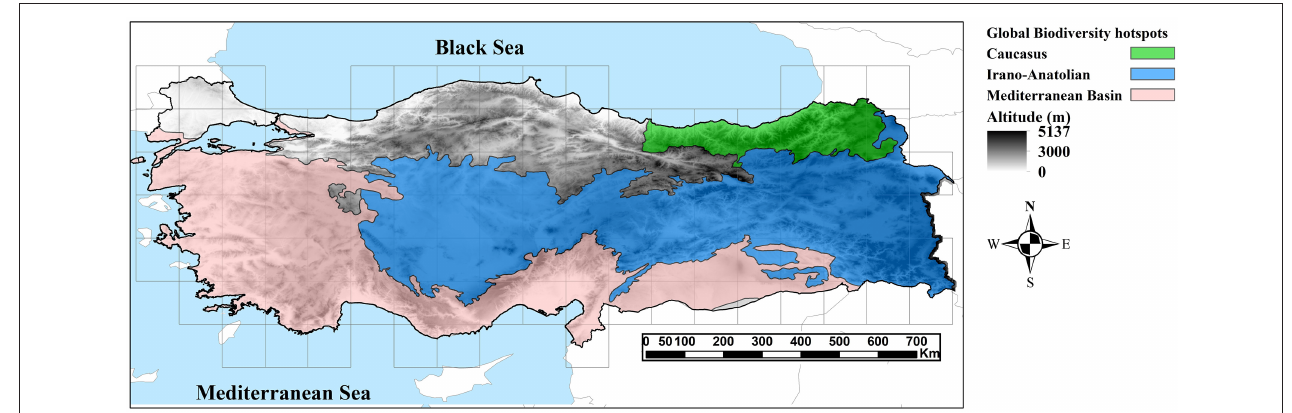
FIGURE 1 | Topographic map of the study area (Turkey) showing the extent of three global biodiversity hotspots in this